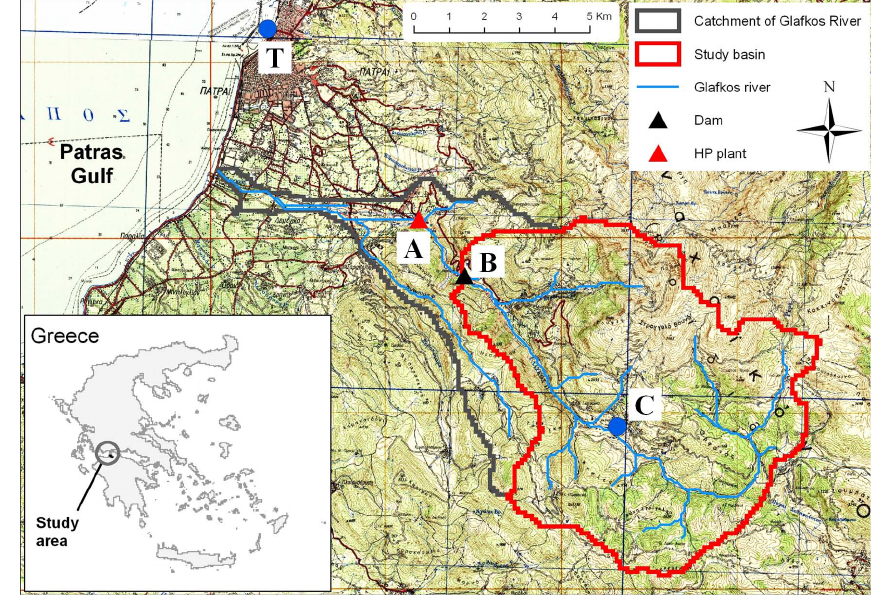
Fig. 2. The catchment of the Glafkos river in West Greece; see Sect. 2 for